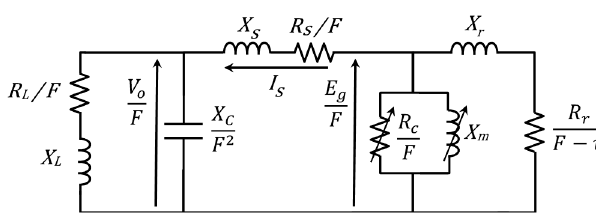
Figure 2. Per-phase equivalent circuit of the induction generator under the proposed core-loss model.